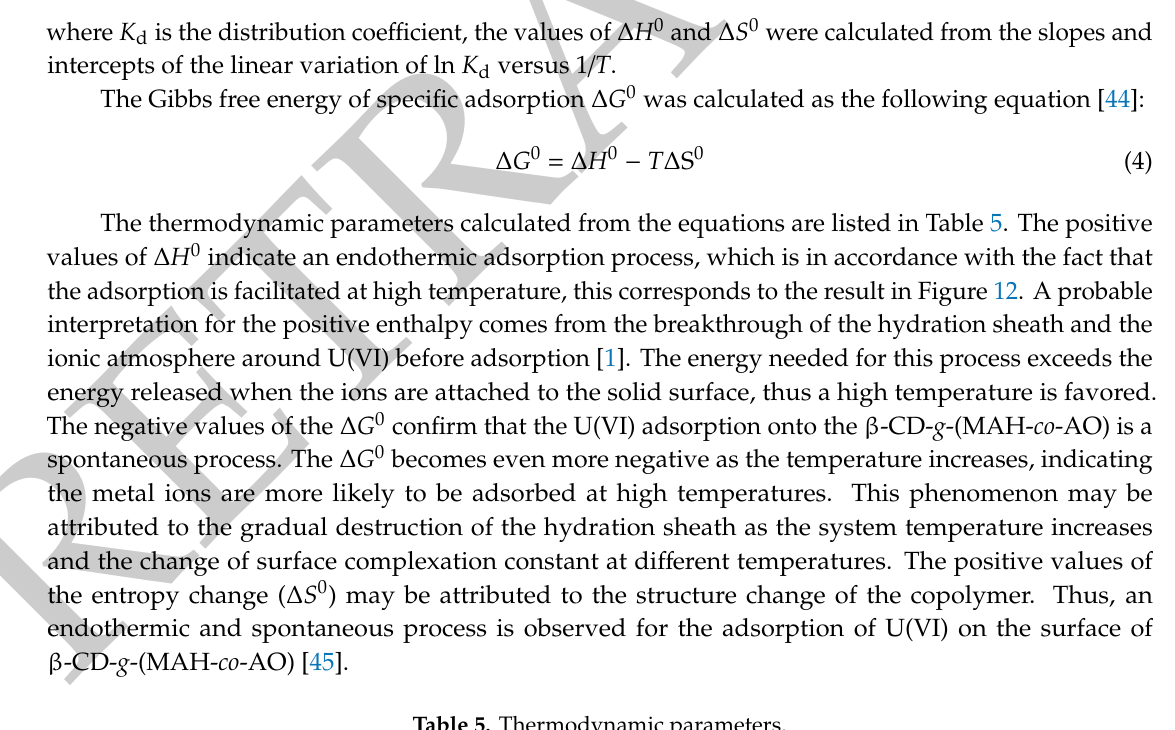
Table 5. Thermodynamic